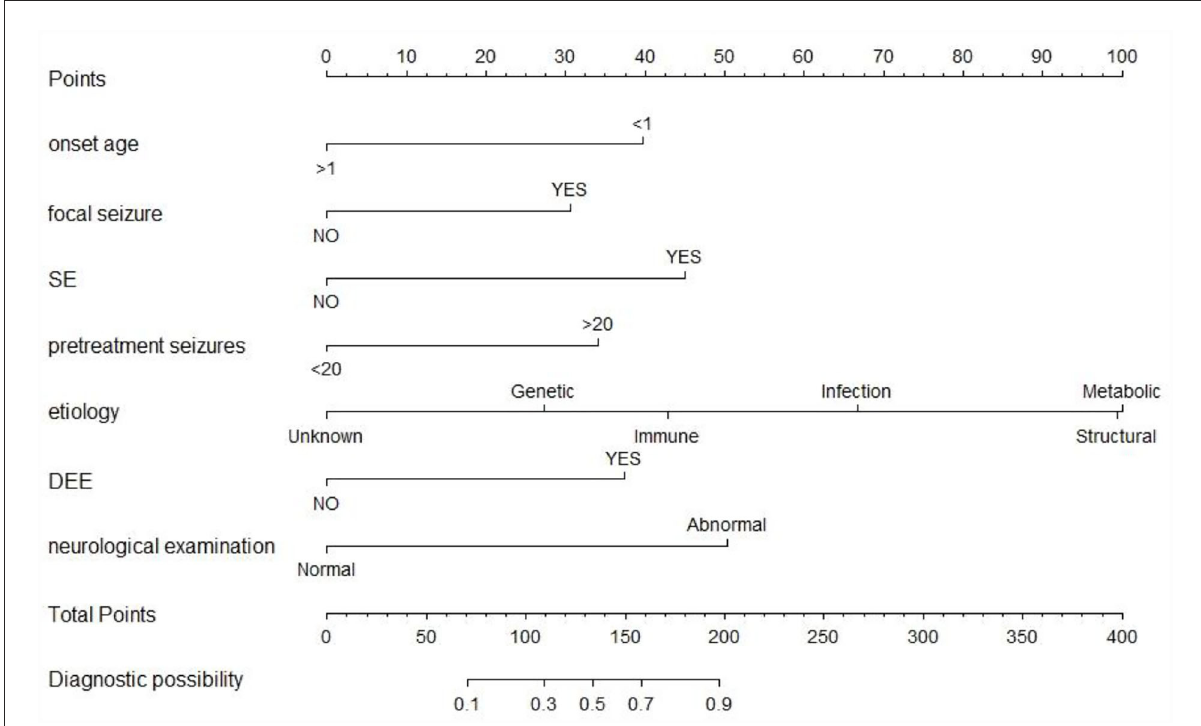
FIGURE2 The nomogram prediction model of individual DRE. SE, status epilepticus; DEE, development and epileptic encephalopathy. The top row is used for point assignments for each variable. Rows 2–8 indicated the variables included in the nomogram. The sum of the points is located on the total points line. The lowest row showed the diagnostic possibility of